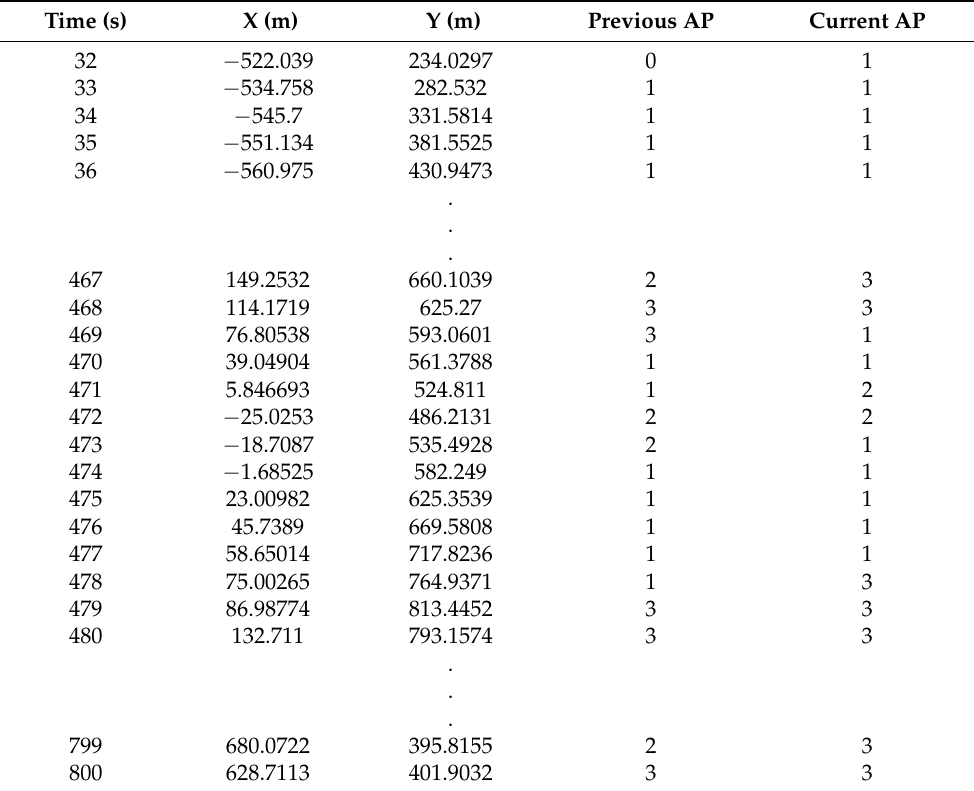
Table 2. Example of a dataset generated using the RSSGM